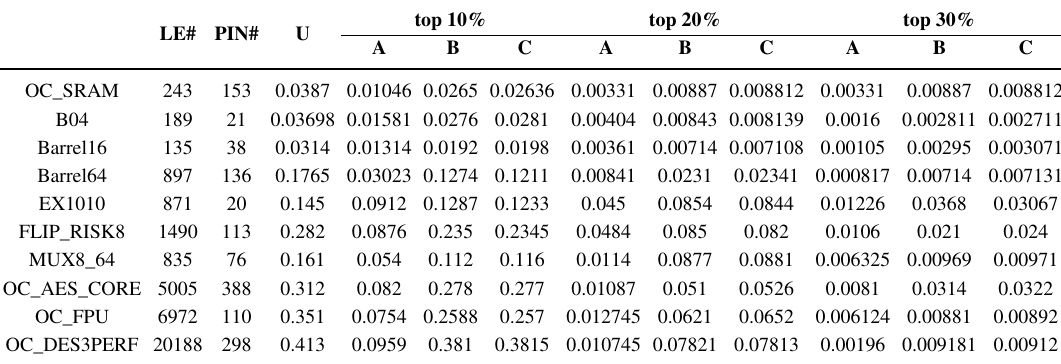
Table 1. Results of the overall error probability P Program (QUIP)